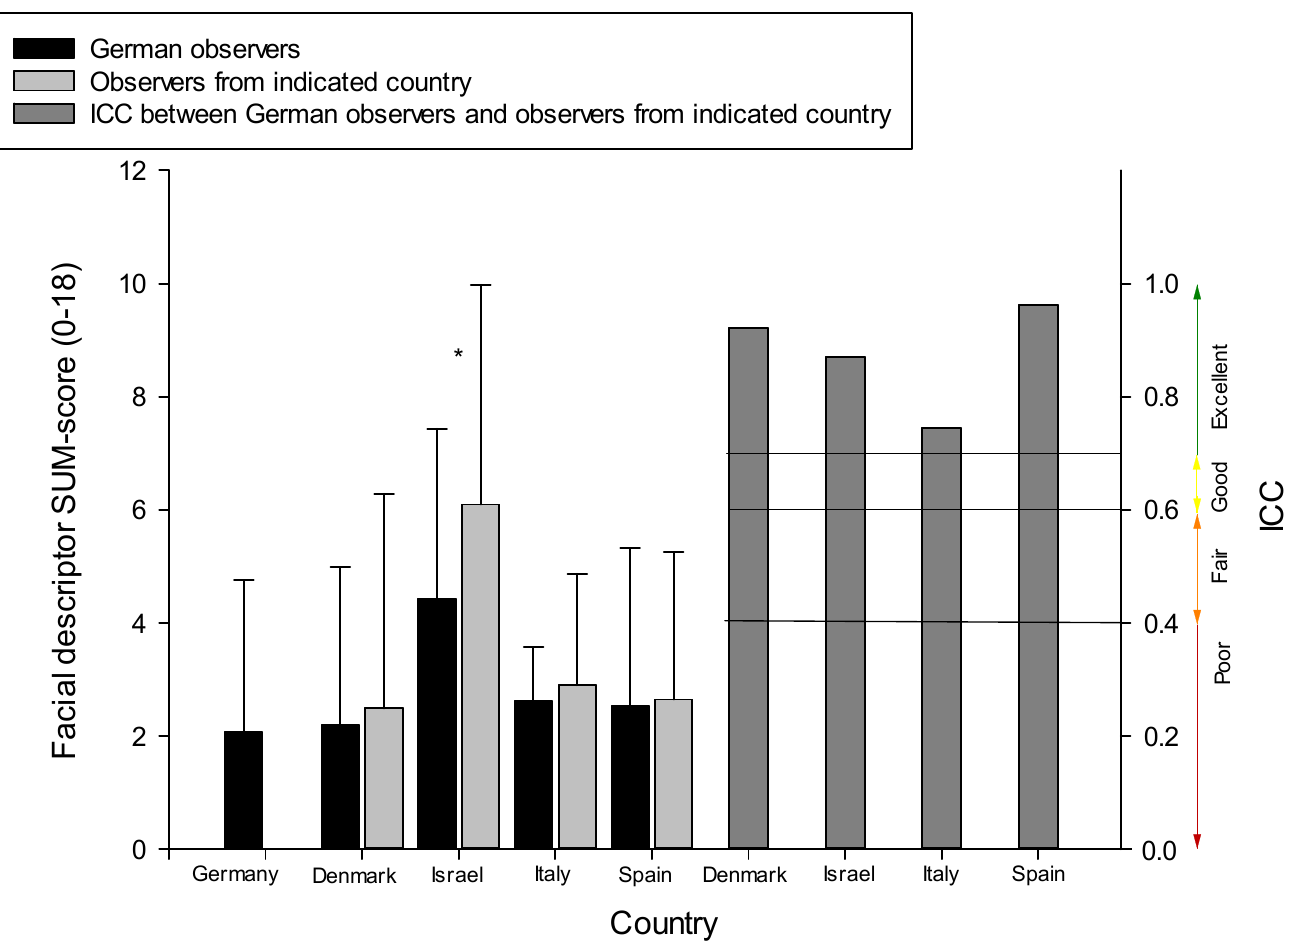
Figure 1. Step 2; decoding–comparison between countries: Mean SUM-scores (SD) of observer ratings for facial responses to 400 kPa pressure (highest pain intensity). Scores are given separately for the German observers (who scored all videos; “gold-standard”) and the observers from each given country. ICC scores (reliability) are presented at the right side between German observers and observers from each given country. The symbol * indicates p < 0.05